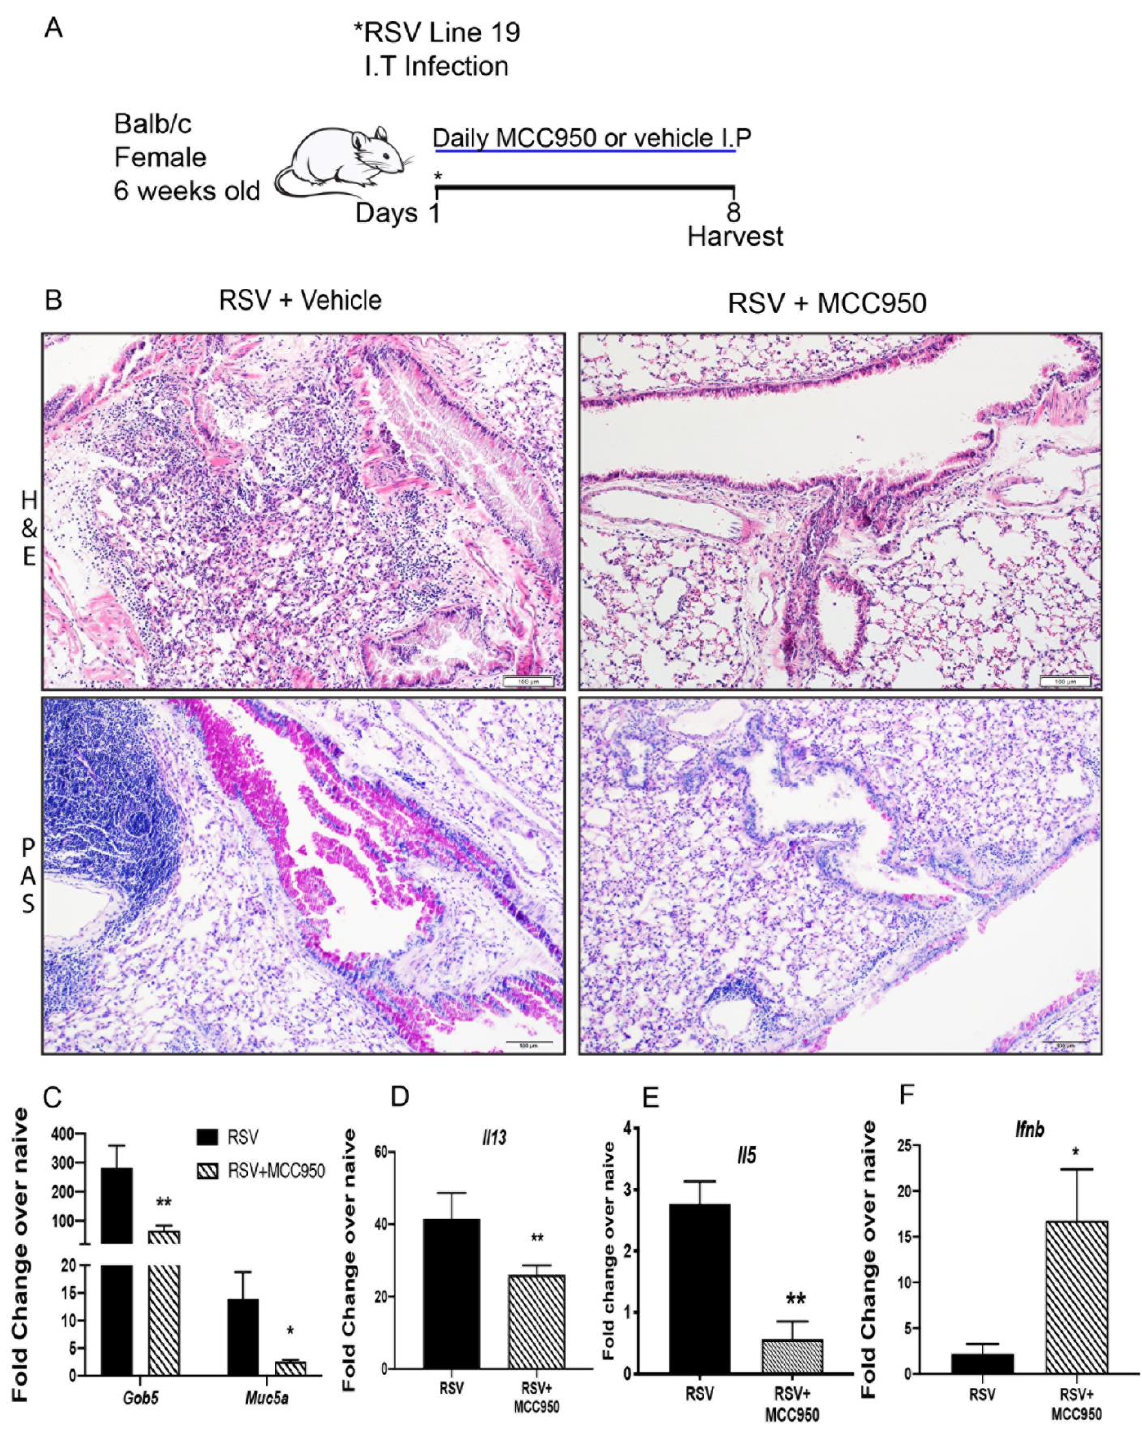
Figure 1. NLRP3-inflammasome inhibition abrogated RSV immunopathology in adult mice. ( A ) 6–7-week-old adult female BALB/c mice were infected intratracheally with Respiratory Syncytial Virus (RSV), Line 19 and treated daily with either an NLRP3 inhibitor (MCC950) or vehicle intraperitoneally; samples were harvested at 8 days post-infection. ( B ) Lung histopathology in Hematoxylin and Eosin stain (H&E) showed strongly reduced lung inflammatory infiltration and Periodic acid-Schiff stain (PAS) detected mucus that was decreased in the RSV+MCC950 group compared with control RSV+Vehicle. ( C ) Decreased Gob5 and Muc5ac lung mRNA expression. ( D ) Il13 and ( E ) Il5 mRNA expression. ( F ) Upregulation of Ifnb lung mRNA expression . Data represent the Mean ± SEM from 4 to 5 mice (experimental repeats 2). * p ≤ 0.05, ** p ≤